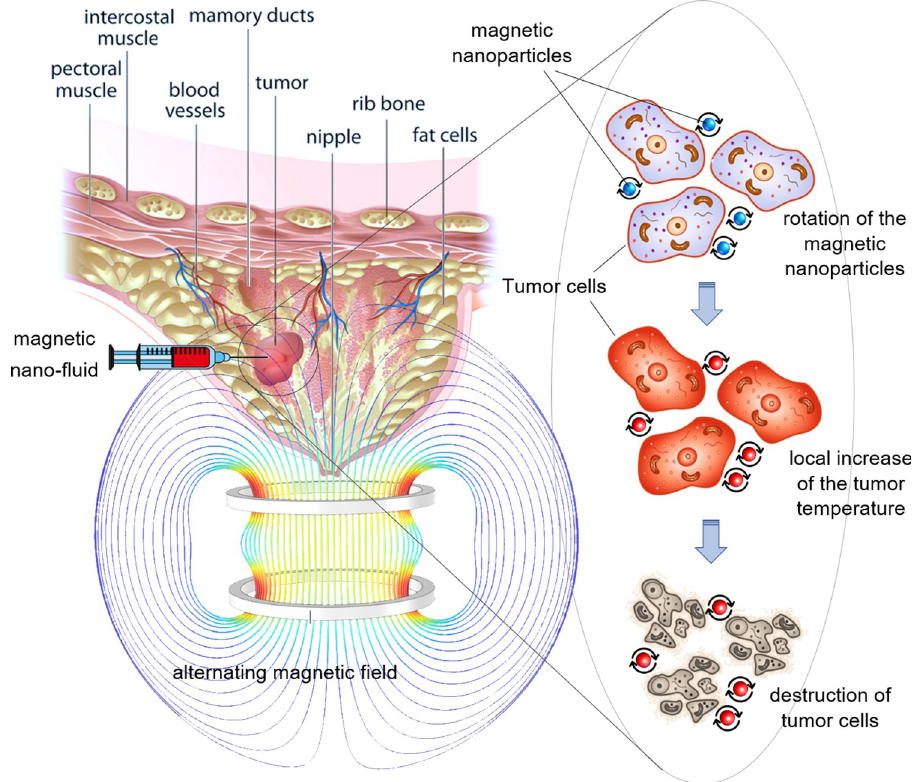
Fig 1. A schematic view of the MFH process of a breast